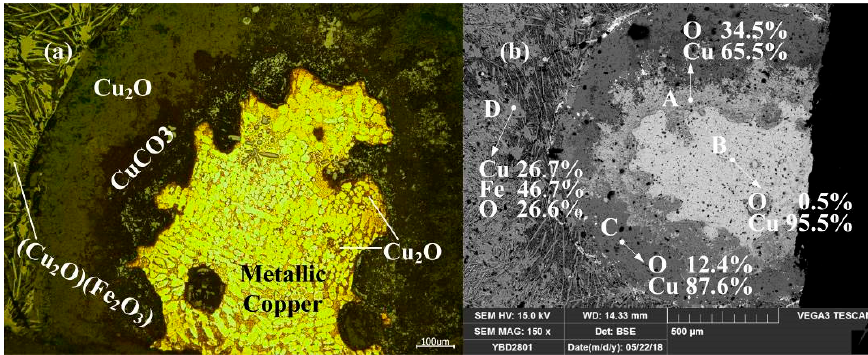
Figure 27. Optical micrograph ( a ) and SEM backscattered electron image ( b ) of YBD24.